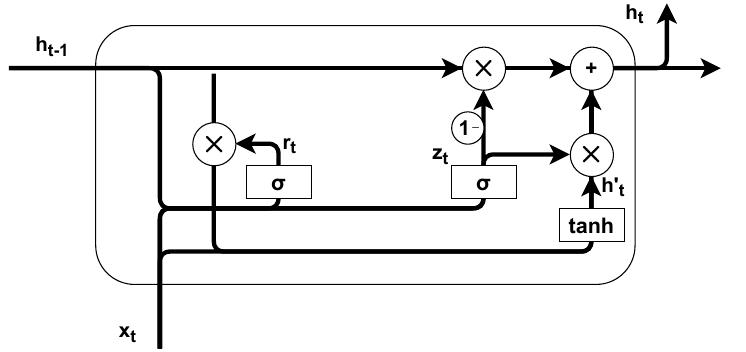
Figure 6. Architecture of a GRU (Gated Recurrent Units)